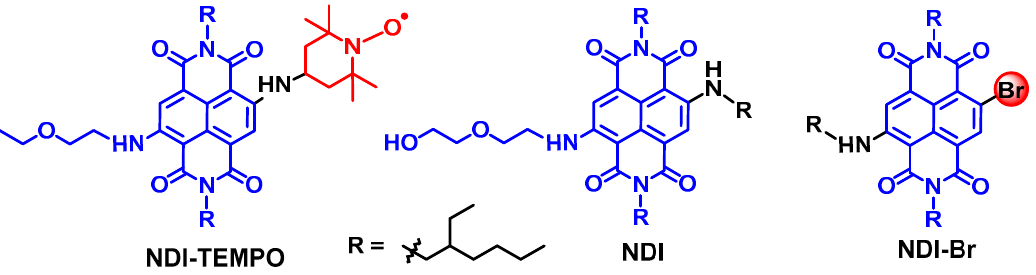
Figure 3. Molecular structures of the chromophore-radical dyad NDI-TEMPO. The molecular struc- tures of the reference compounds NDI and NDI-Br are also